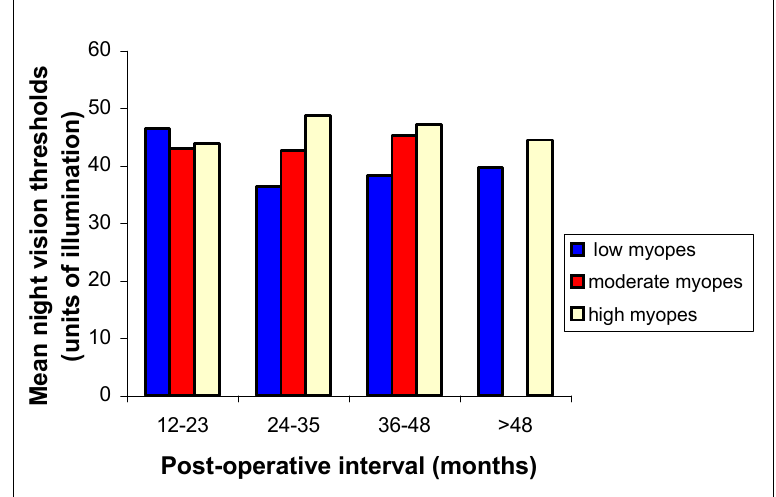
Figure 1 .Mean night vision thresholds according to degree of pre-operative refractive error and the post-operative interval